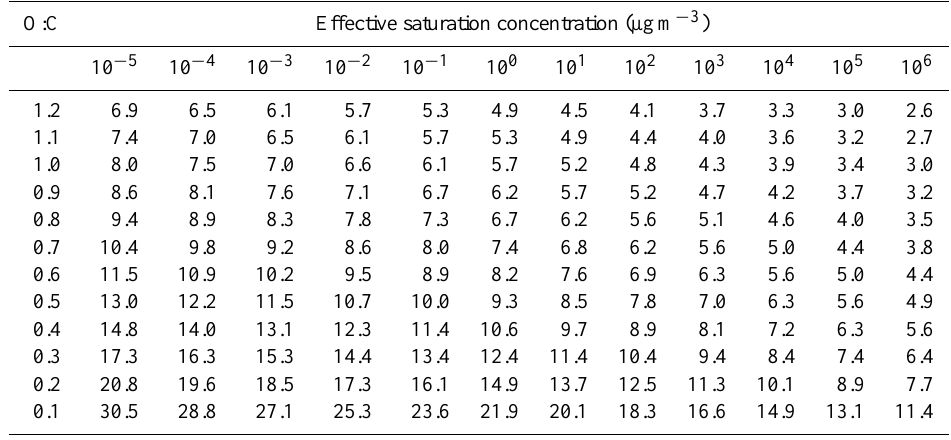
Table 1. Carbon number as a function of effective saturation concentration and O:C in the 2D-VBS.